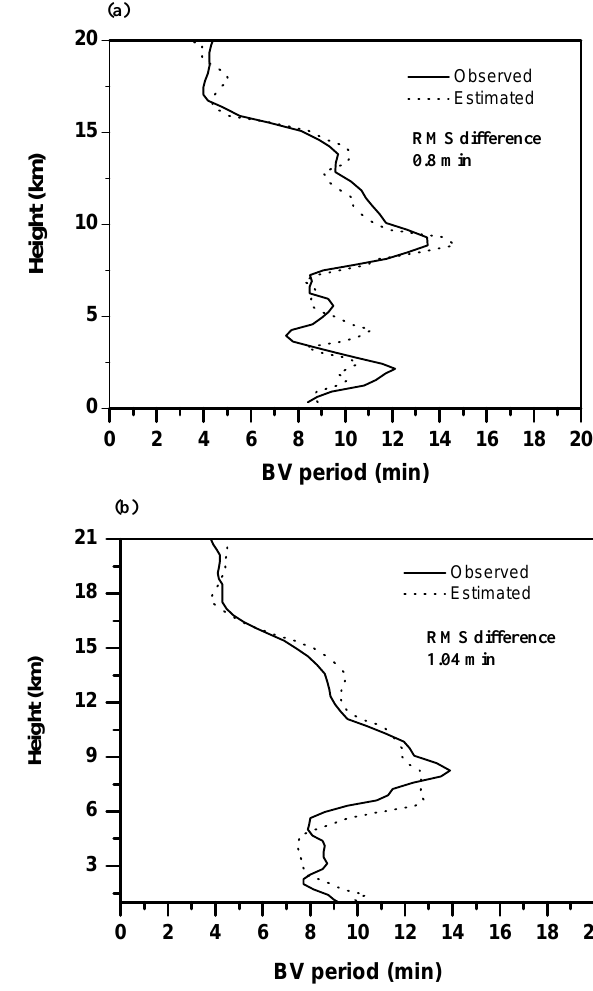
Fig. 5. Height profiles of Brunt-V¨ais¨al¨a period derived using wavelet analysis (dashed) and temperature sounding (solid) on (a) 2 September 2002 and (b) 12 September 2002 at